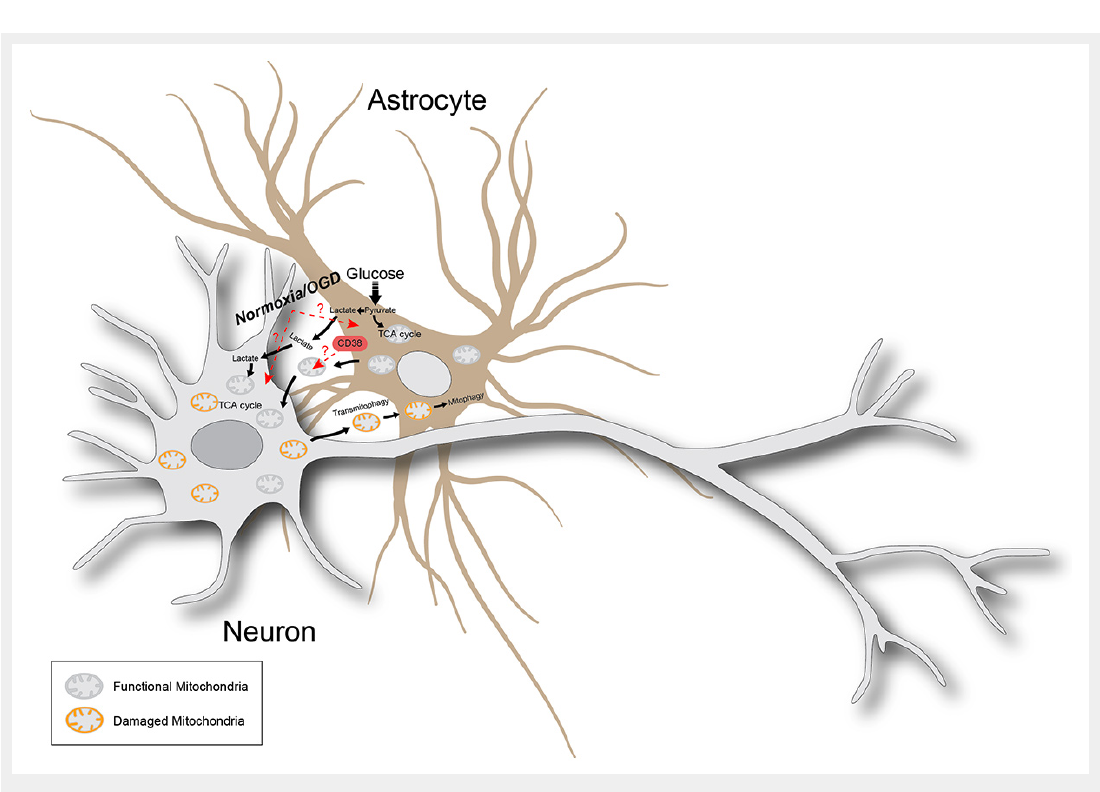
Metabolic-coupling between astrocytes and neurons following hypoxia . Astrocytes, which are highly glycolytic cells, are metabolically coupled with neurons in several ways. First, they can generate L-lactate from glucose and exchange it with neurons as a substrate for energy production (lactate shuttle). Second, they can transfer functional mitochondria (both via direct cell-to-cell contact and/or extracellular vesicles) to hypoxic neurons, thereby increasing aerobic respiration. Finally, damaged/dysfunctional mitochondria can be transferred from neurons to astrocytes to support their degradation via transmitophagy. Red dashed arrows with question marks indicate the main mechanistic questions left open following the breakthrough work by Hayakawa and colleagues: the role of hypoxia (vs normoxia) in regulating mitochondria release and transfer; the ability of hypoxic astrocytes to release functional mitochondria, and the role of CD38 in orchestrating the release of